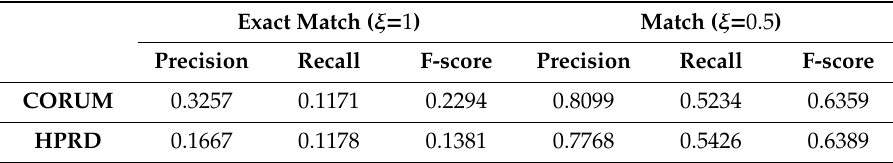
Table 2. Graph clustering performance on CORUM [4] and HPRD